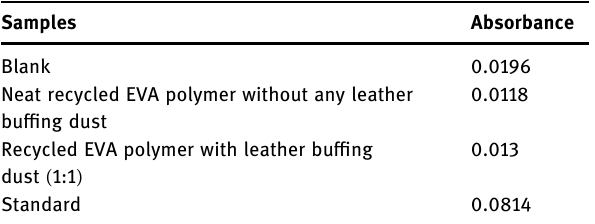
Table 4: Absorbance values obtained with water testing